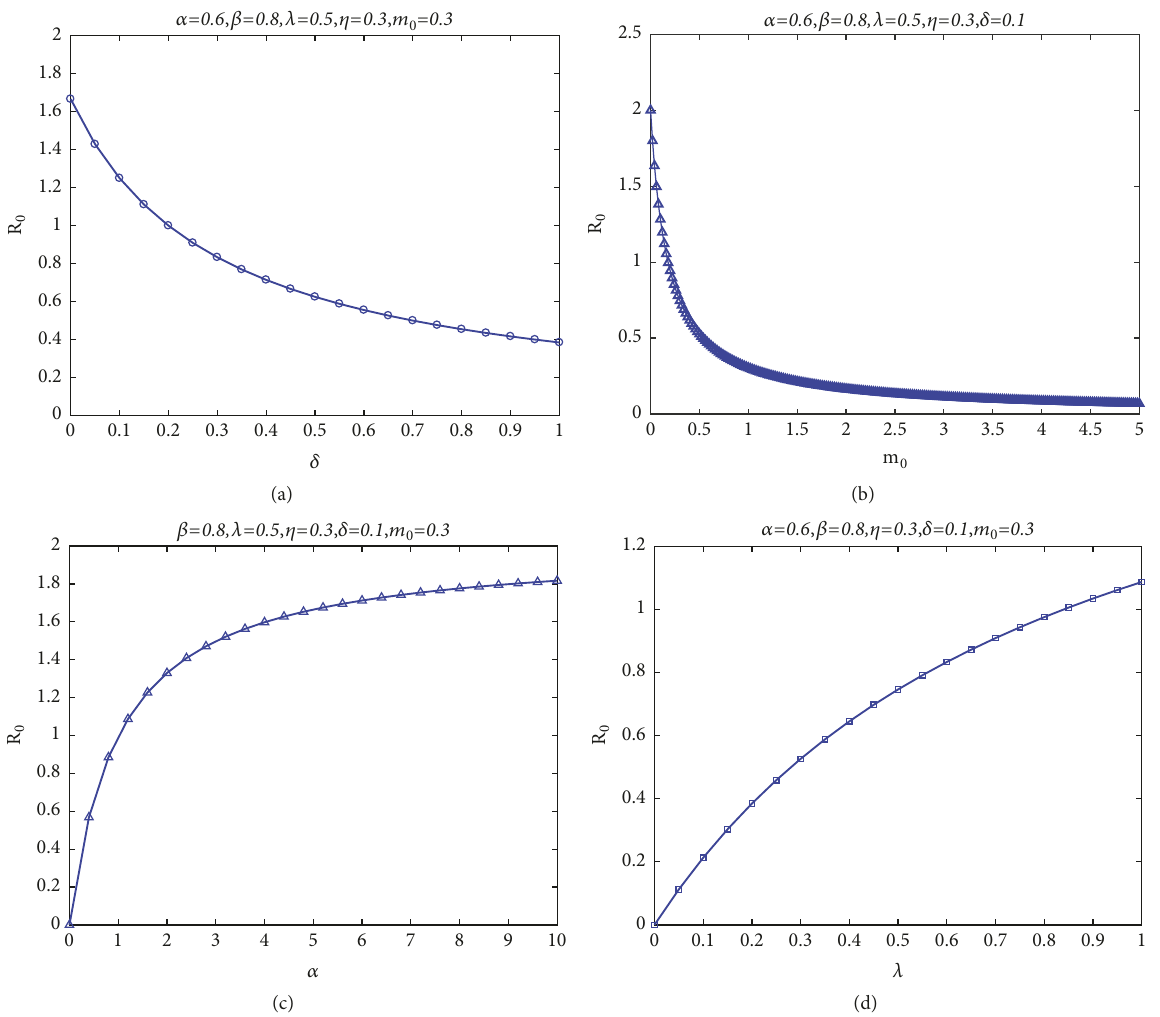
Figure 2: The relationship between the basic reproduction number R 0 and the model parameters 𝛿 , 𝑚 0 , 𝛼 , and 𝜆 on BA scale-free